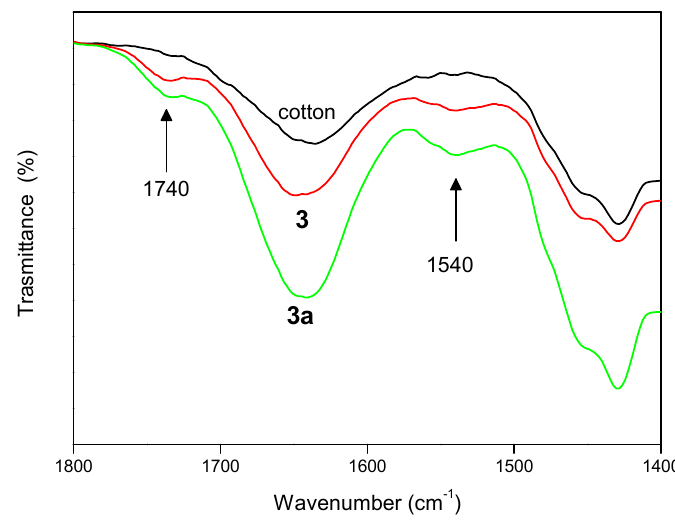
Figure 2. FT-IR spectra (KBr disc) of cotton (black) and sample 3 (red) and 3a (green).